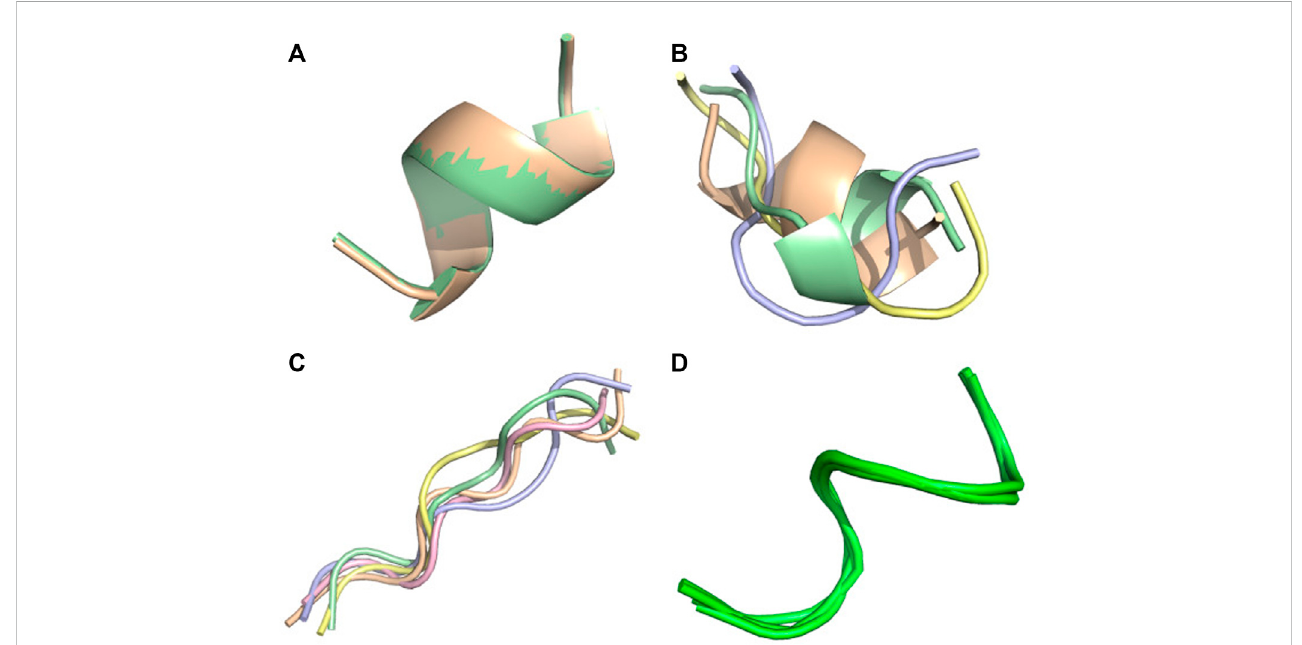
FIGURE 4 Conformational ensemble of 6 nm3. (A) PF-noDH, (B) PF-DH at pH 4.3, (C) AlphaFold2, (D) NMR structure. For A, B and C, the 5 predicted models are depicted. For D, all models provided in the PDB are